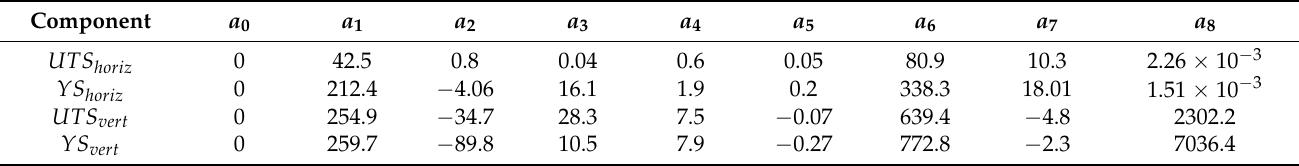
Table 7. Calculated coefficients for the linear regression models of horizontal and vertical components of UTS and YS for